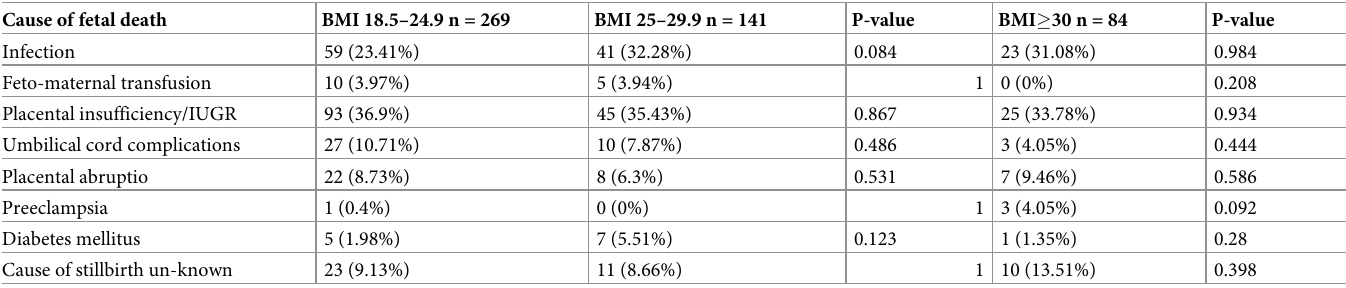
Table 4. Cause of fetal death in term pregnancies complicated by stillbirth in Stockholm county 2002–2018, divided according to maternal pre-pregnancy BMI. Cause of fetal